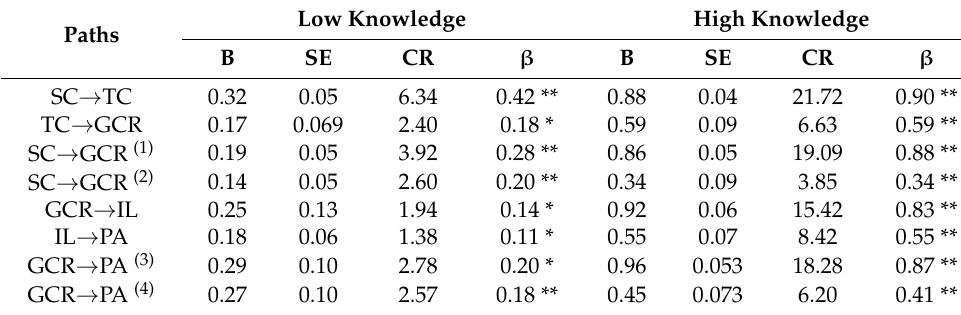
Table 7. Results of the path analyses of the two groups. Low Paths